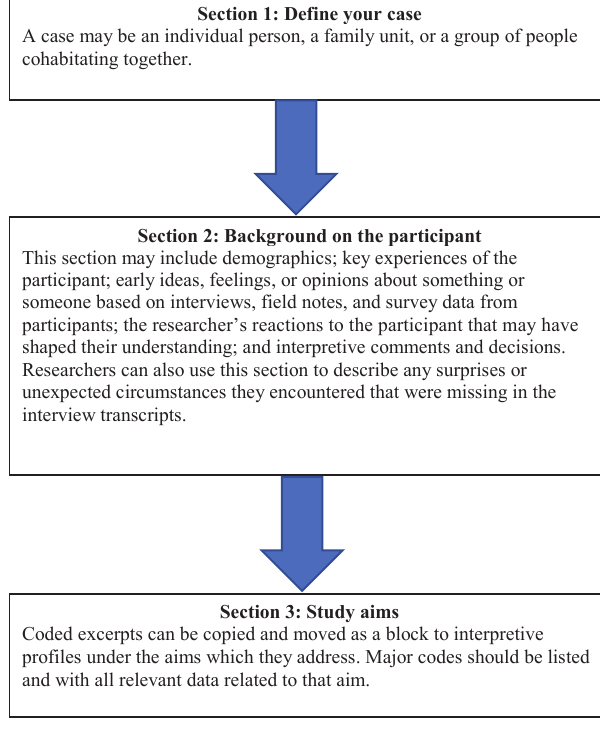
Figure 1. Creation of an interpretive